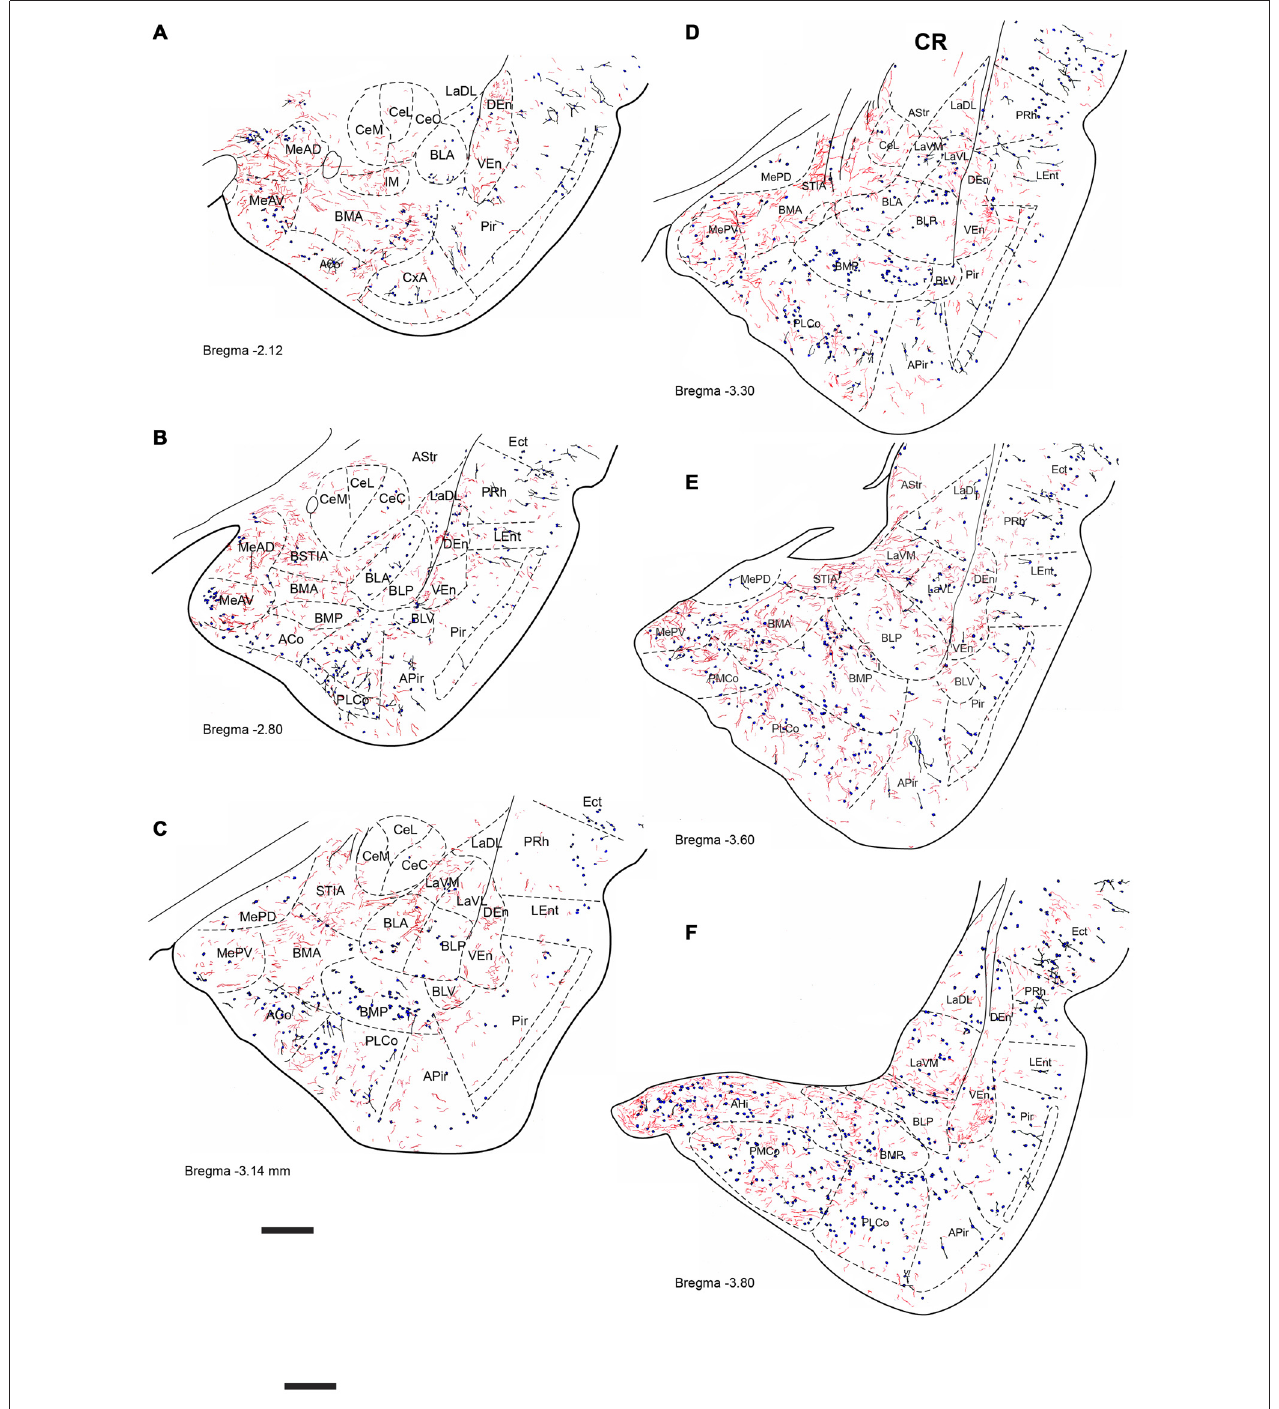
FIGURE 7 | Distribution of relaxin-3-positive fibers in the TA relative to the distribution of calretinin (CR)-positive neurons . Relaxin-3 fibers located in the medial and caudal amygdala areas. (A–F) Camera lucida drawings of the corresponding Bregma levels. Calibration bar 250 µ m.